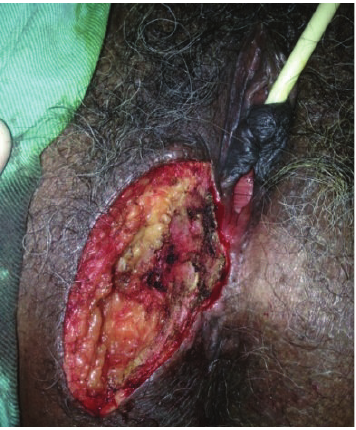
Figure 2: Photograph taken during surgery showing resection margins.